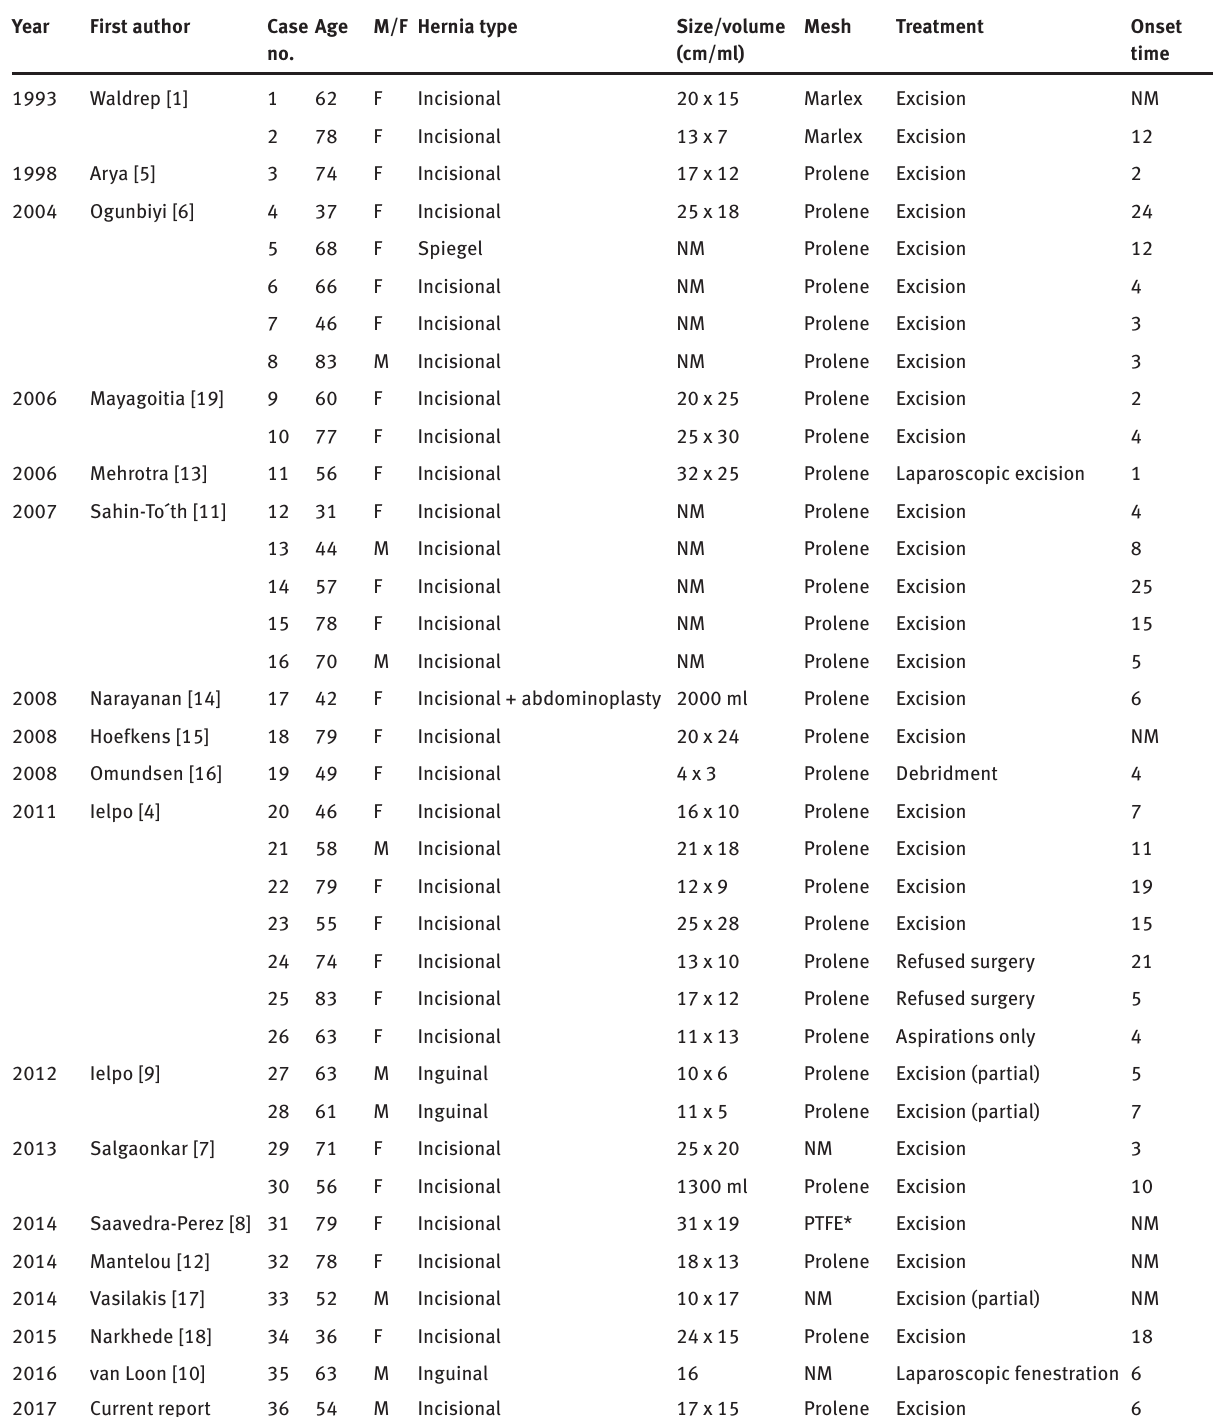
Table 1: Case reports of pseudocysts after hernia repair with